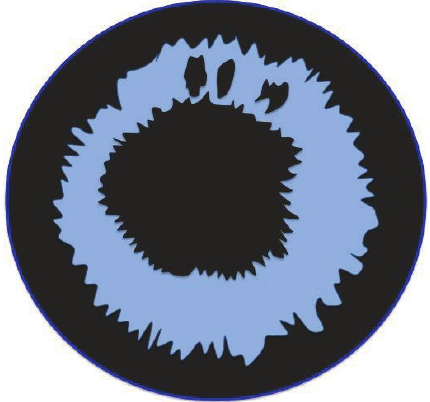
Figure 4: The opposite pattern observed on an IOL